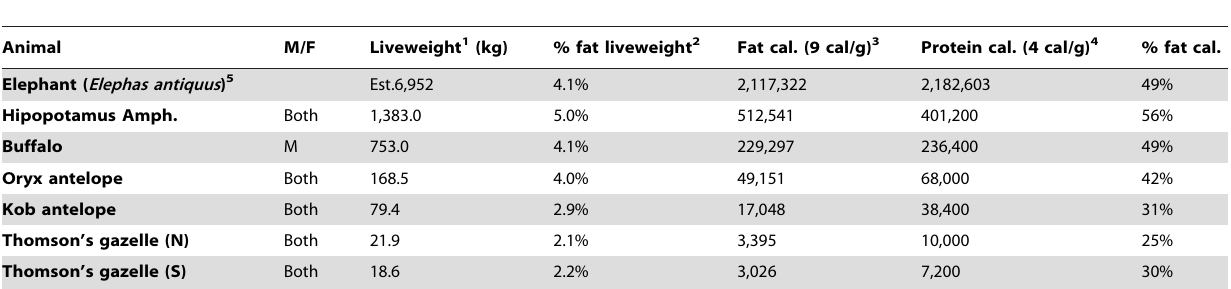
Table Notes. 1 Excluding brain, heart, liver, tongue together comprising approximately 5% of edible tissue by weight ([157]:1626). 2 All numbers for fat with the exception of the elephant are based on Bunn and Ezzo ([3]:370 after Ledger ([87]). Cancellous fat is excluded. 3 Fat yield=82% of fat weight. Based on Cordain et al. ([88]:152) after Crawford et al. ([89]). 4 Protein content based on Ledger ([87]:299). 5 Elephant weight based on Christiansen ([158]: Table 7); fat to protein proportion based on buffalo here. Due to lack of data regarding fat and protein content of elephants, and ancients one at that, our calculations are based on the next largest terrestrial animal mentioned by Ledger ([87]) – the buffalo. As the proportion of fat increase with the size of the animal ([159]), the estimated fat content and total calories supplied by the elephant are likely underestimated. doi:10.1371/journal.pone.0028689.t003 PLoS ONE |